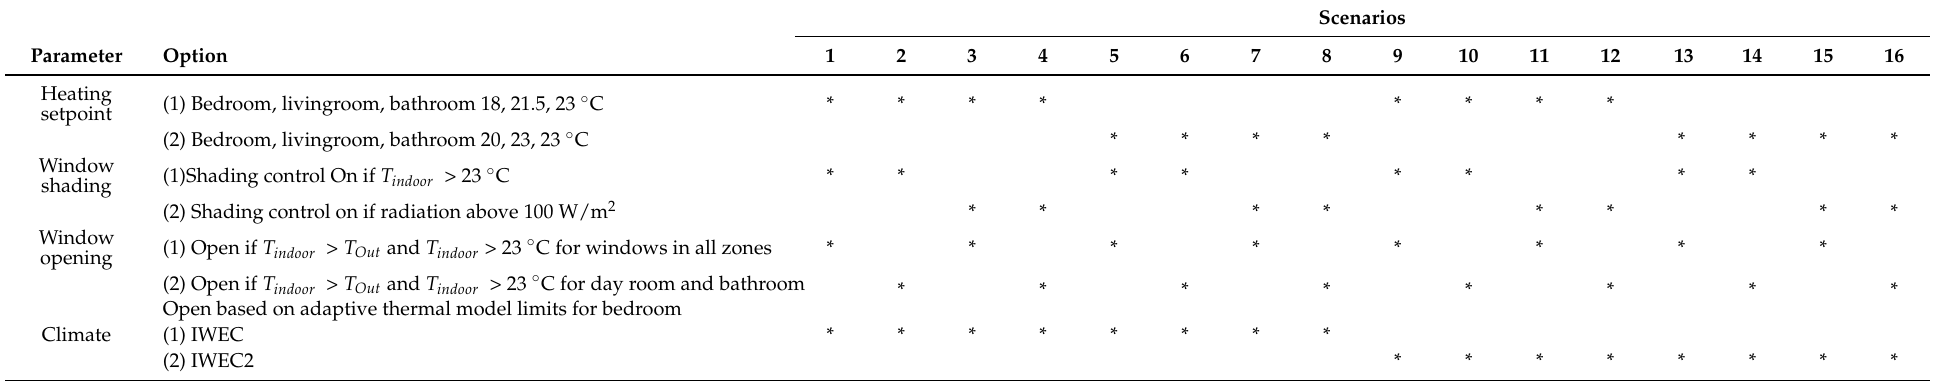
Table A1. Summary of the occupant behaviors and climate parameters and their combinations into the 16 considered scenarios. * shows the chosen option for each parameters in the